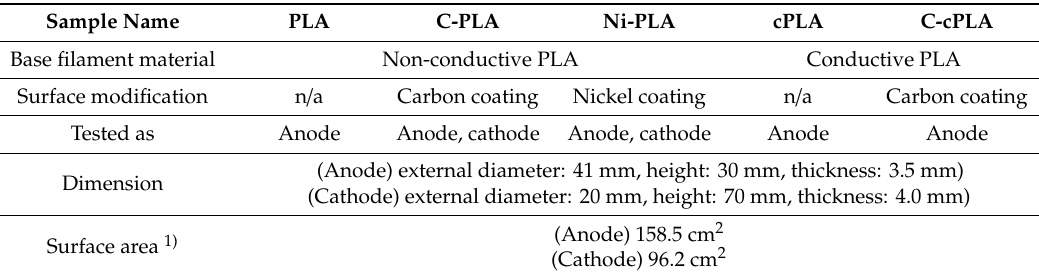
Table 3. Details of 3D printed electrodes tested in the study.